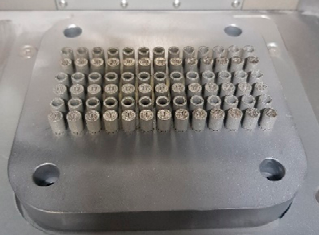
Figure 6. Samples for the static and dynamic compressive tests on the SLM 125 HL machine building platform.